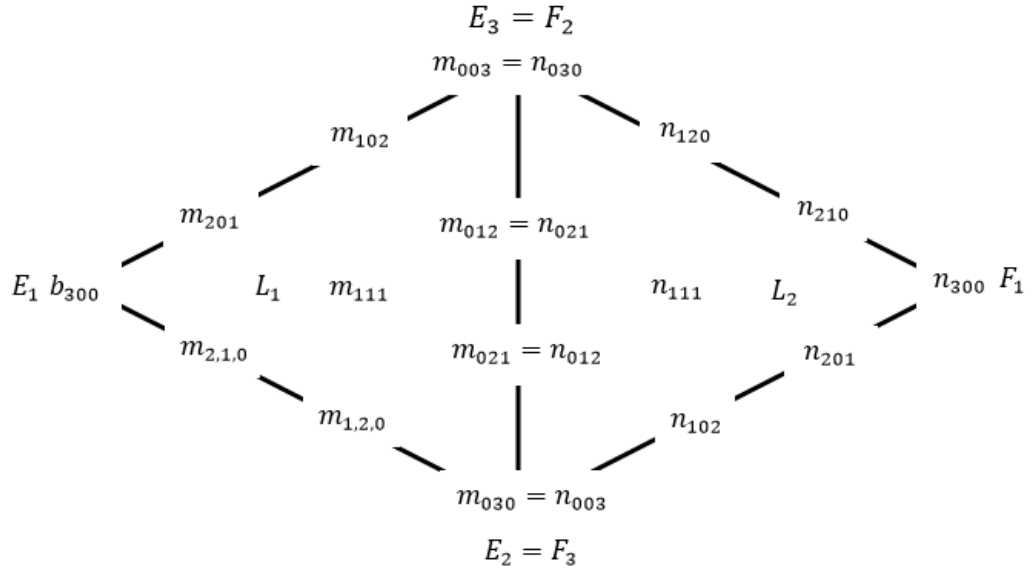
Figure 6. Two adjacent cubic triangular patches for Foley and Opitz [19].